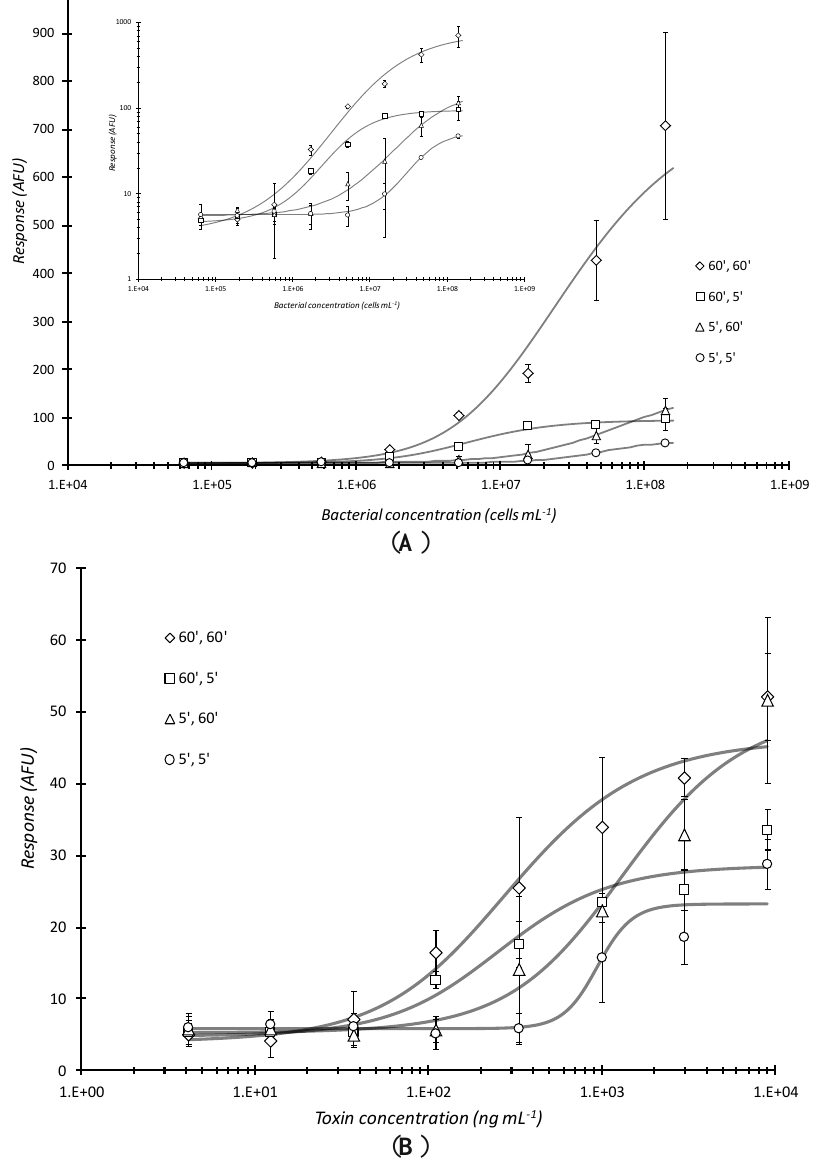
Figure 2. Effects of varying analyte and conjugation reaction times on microarray detection of bacterial cells or toxin. Serially diluted analyte, live E. coli O157:H7 ( A ) or Stx1 ( B ) were statically incubated in microtiter plates microarray printed with passively adsorbed biotinylated capture antibodies for the first time (5 or 60 min) indicated and then further reacted with fluorescent dye labeled antibody conjugates for the second time (5 or 60 min) also indicated. As with all subsequent plots in this report, the above curves show the microarray response in arbitrary fluorescence units (AFU) versus bacterial or toxin concentration. Each data point represented the mean ± standard deviation for 4 of 8 daily technical replicates (with 2 highest and 2 lowest values dropped) from serial dilution series combined with other similarly treated replicates from experiments repeated no less than 2 days and no more than 4 days.